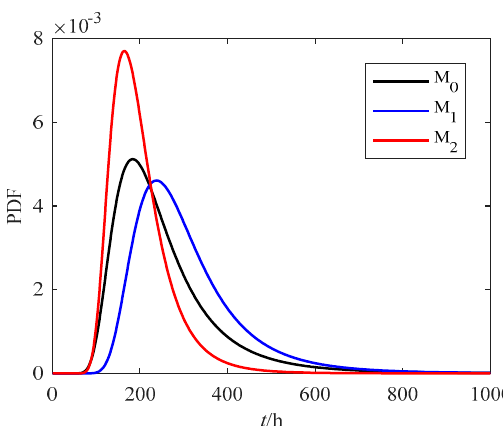
Figure 8. Comparison of PDF of storage lifetime at 60 °C for O-type rubber seal rings.